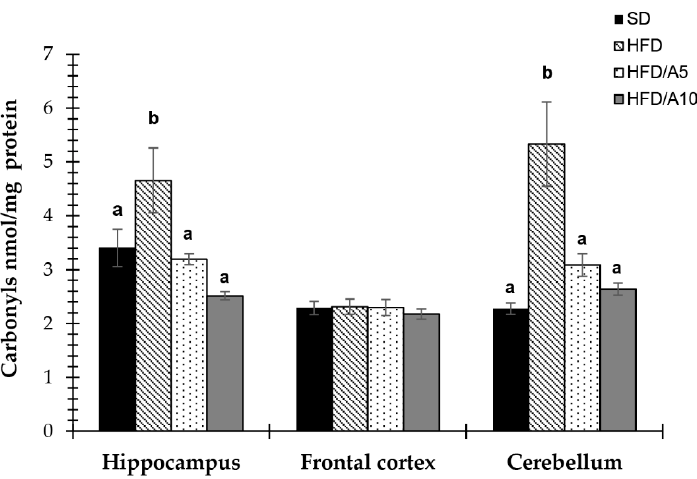
Figure 6. Effects of fructans on protein carbonyls levels in the hippocampus, frontal cortex and cerebellum of mice fed with standard diet (SD); high-fat diet (HFD); high-fat diet with agave fructans 5% (HFD/A5); high-fat diet with agave fructans 10% (HFD/A10). One-way ANOVA and Tukey contrasts were performed to compare differences among groups. The data are represented as the mean with their standard errors of the mean (SEM). N = 10. Mean values with unlike letters (a,b) were significantly different ( p <